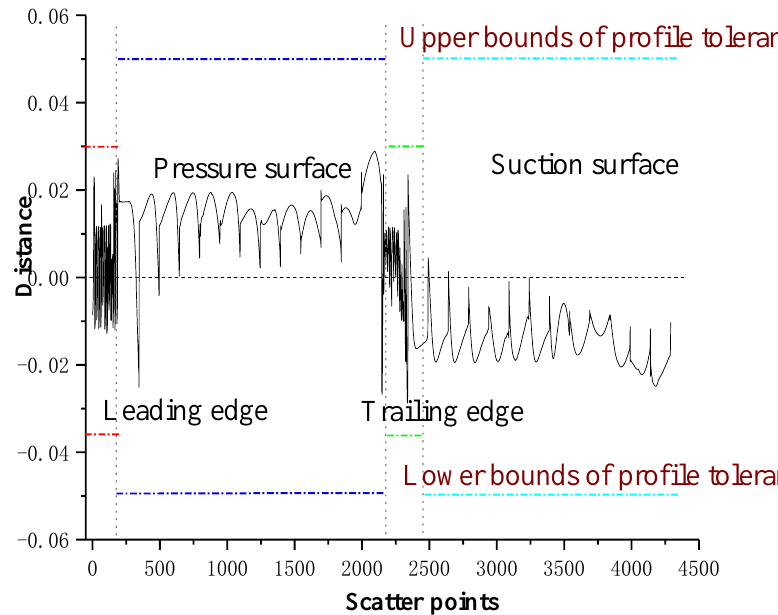
Figure Figure 14. The distances from the profile curves to the tolerance bands with multi-constraint opti- mization.